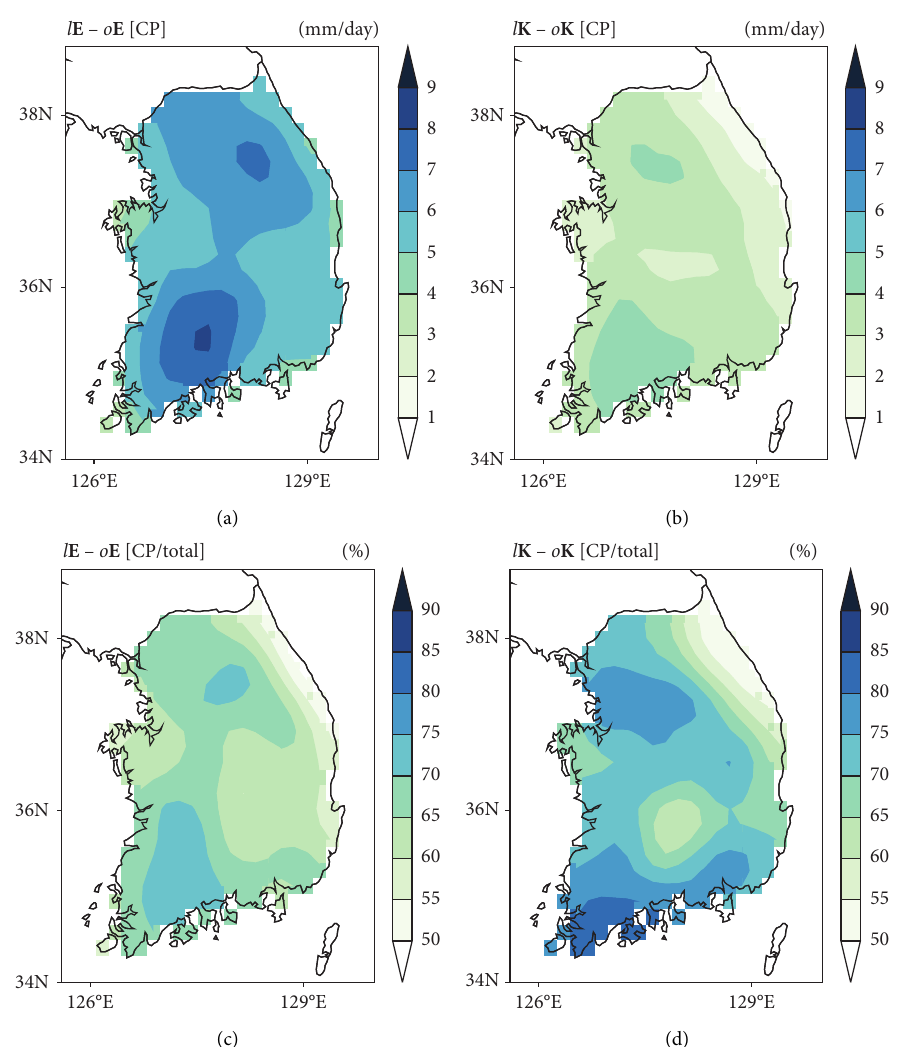
Figure 9: Spatial distribution of (a), (b) convective precipitation (mm/day) and (c), (d) its ratio with respect to total precipitation (%) derived from l E − o E and l K − o K